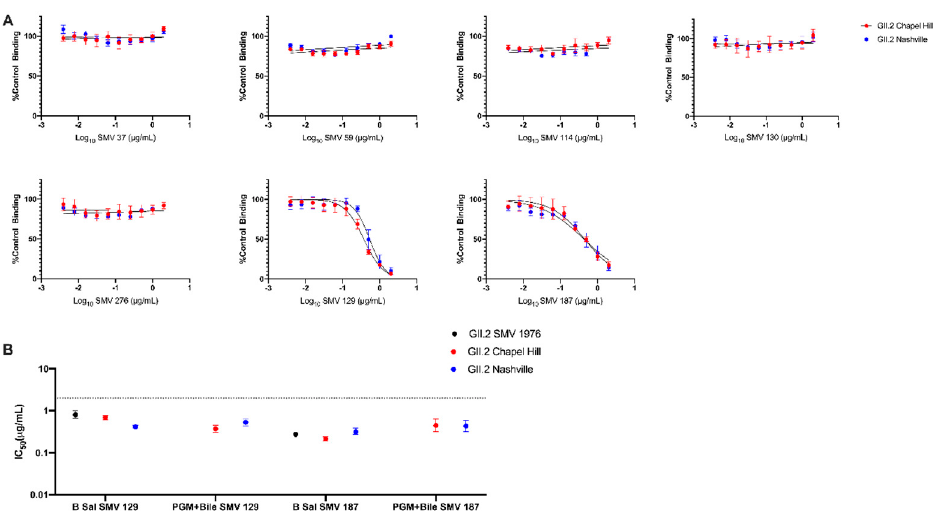
Figure 4. Bile does not affect antibody blockade of Contemporary GII.2 VLP binding to ligands . ( A ) Contemporary GII.2 VLP blockade of PGM binding by mouse monoclonal antibodies is maintained in the presence of 1% bile. Error bars represent standard error of the mean. ( B ) IC 50 values obtained for SMV 129 and SMV 187 on different ligand sources, with and without bile. Sigmoidal dose–response curves were fit to the mean percent control binding for blockade assays, and the IC 50 was calculated in µg/mL. Dashed line represents limit of detection. Error represents 95% confidence intervals.